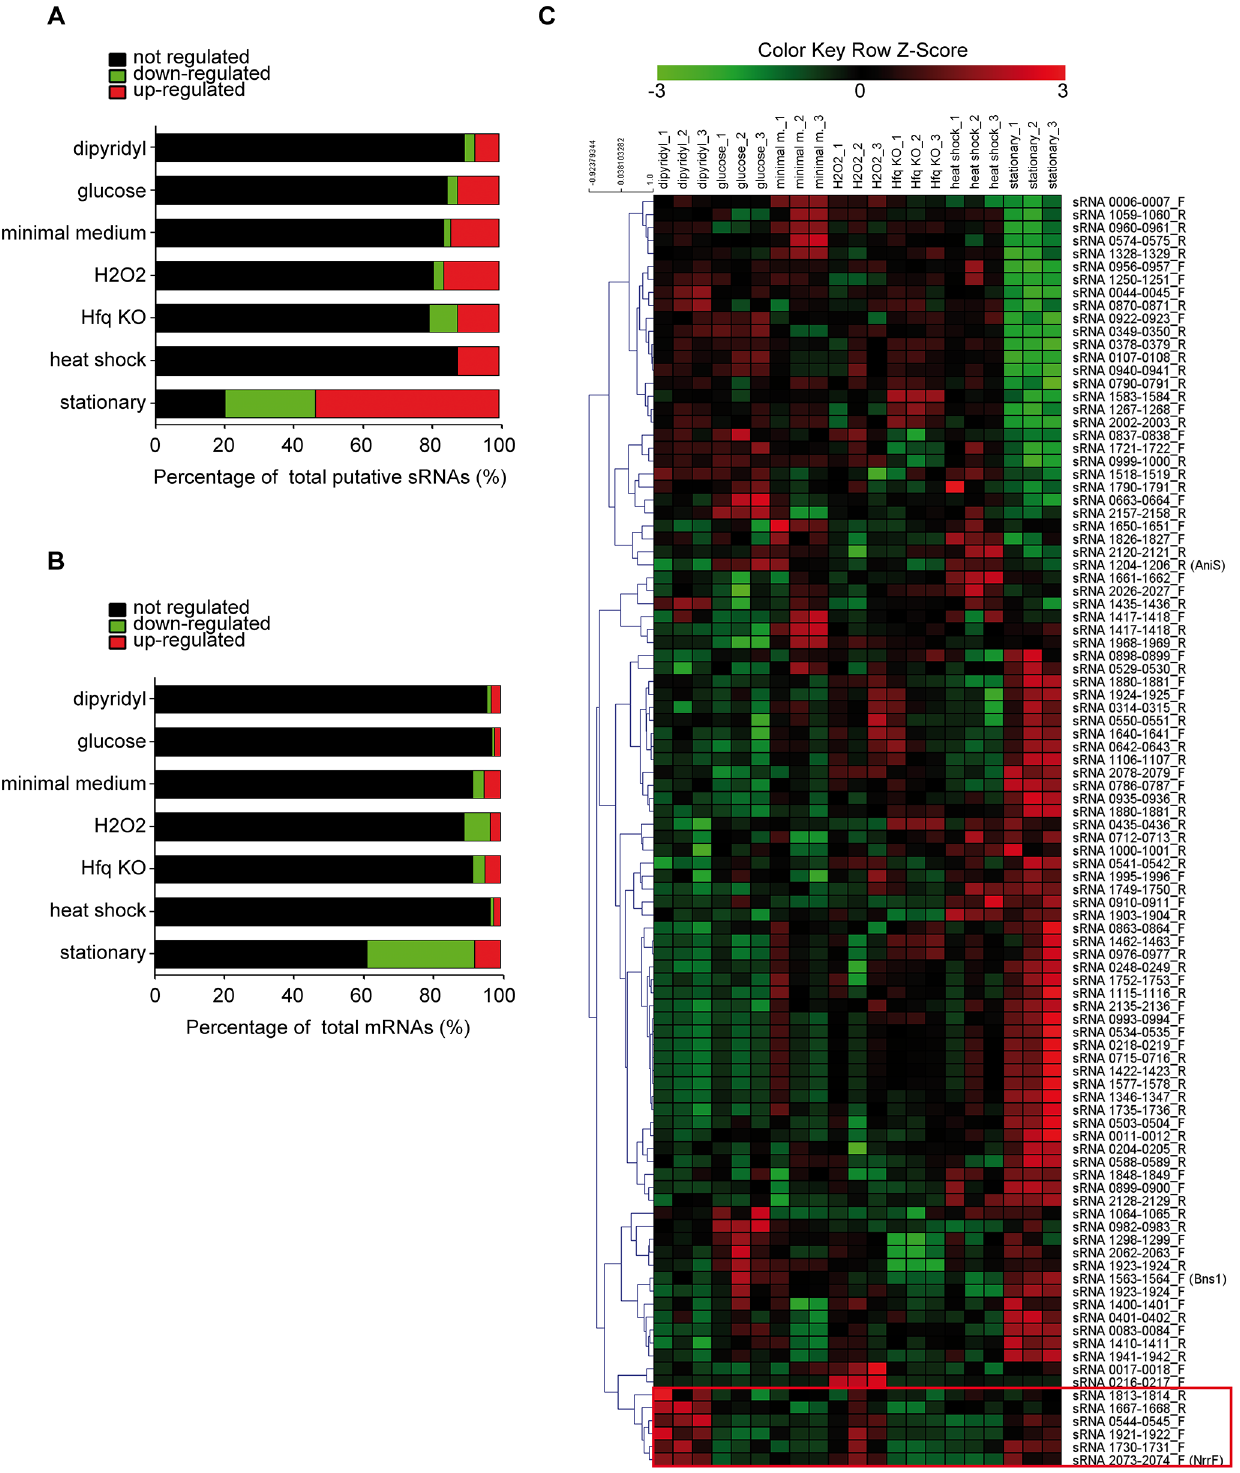
Fig 2. Identification of putative sRNA regulated in different conditions. (A-B) Bar plot percentages of the up- (red), down- (green) and not-regulated (black) total putative sRNAs (A) and mRNAs (B) in all the conditions tested. (C) Heatmap visualization of the 98 putative sRNAs according to their regulation in each individual microarray experiment (21 columns), showing an unsupervised hierarchical clustering analysis (complete linkage, Euclidean distance matrix) of putative sRNA, generated with the TM4 MeV v4.9 software. The colour key scale of raw-Z scores is defined on top of the heatmap. A red squared box underlines the group of sRNAs which cluster with